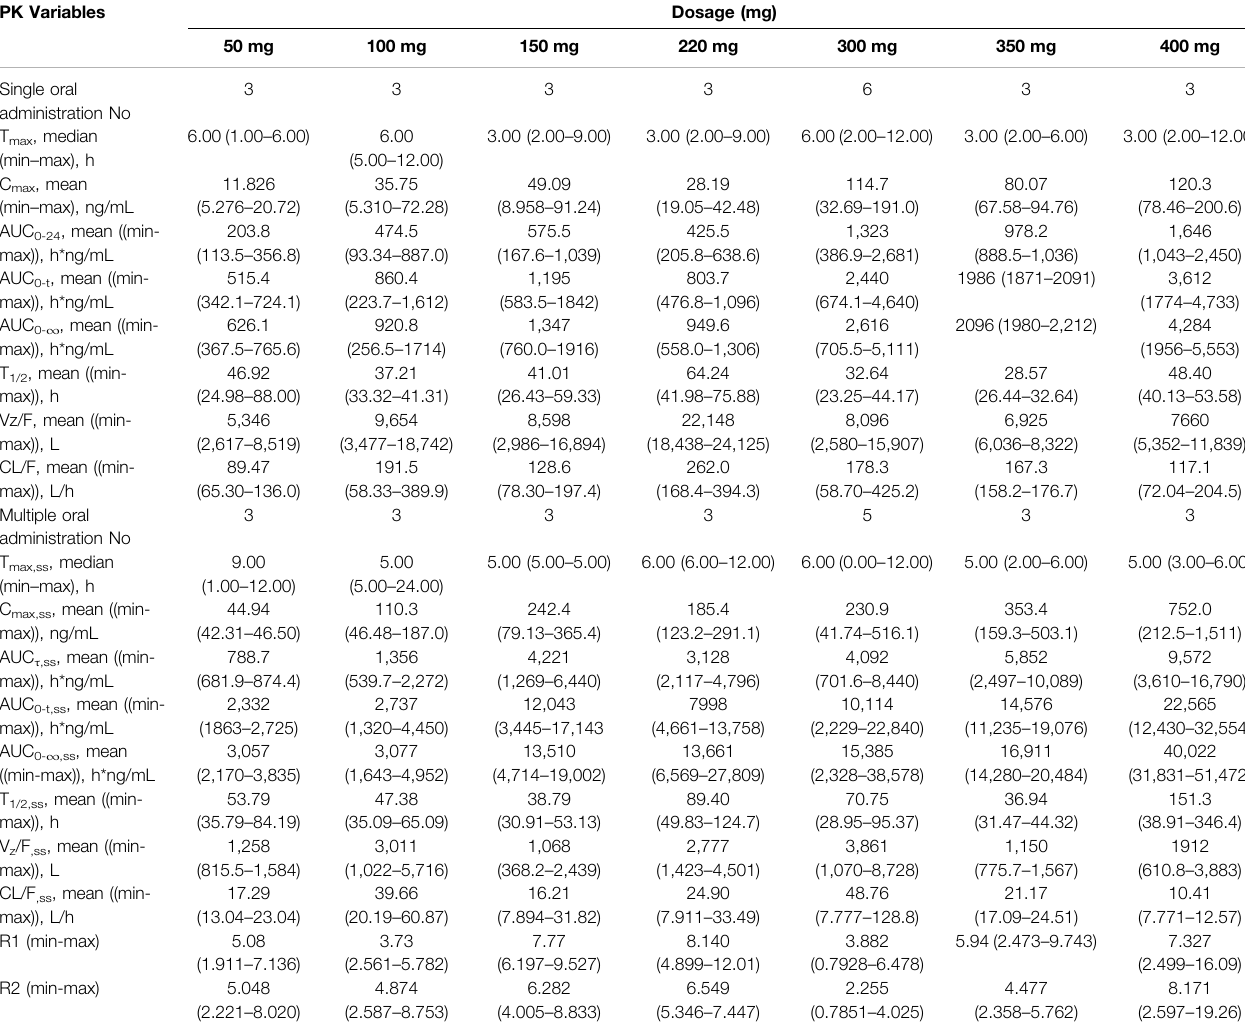
TABLE 4 | Pharmacokinetic (PK) properties of M5 after oral administration of single and multiple doses of 50-, 100-, 150-, 220-, 300-, 350- and 400-mg larotinib mesylate tablets.